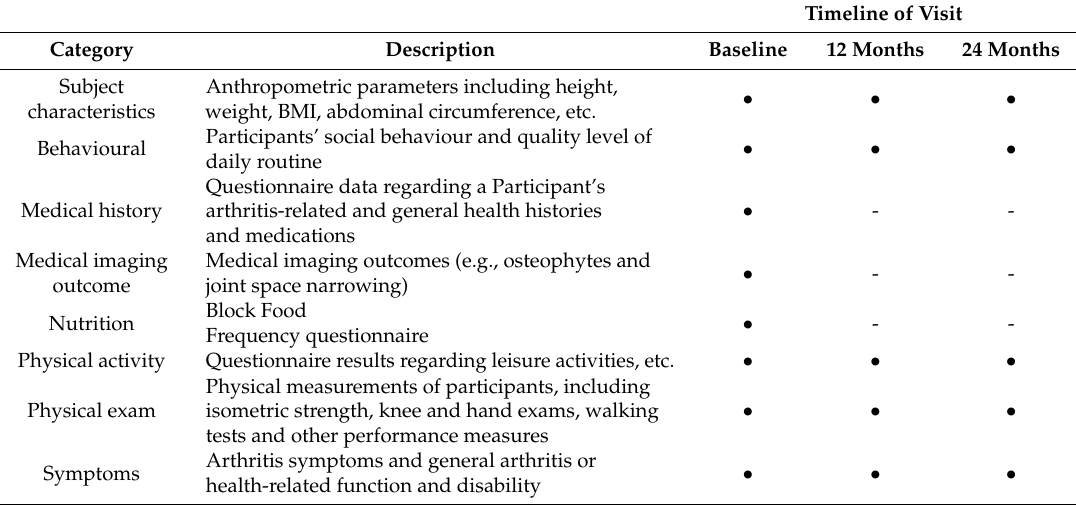
Table 1. Main categories of the feature subsets considered in this